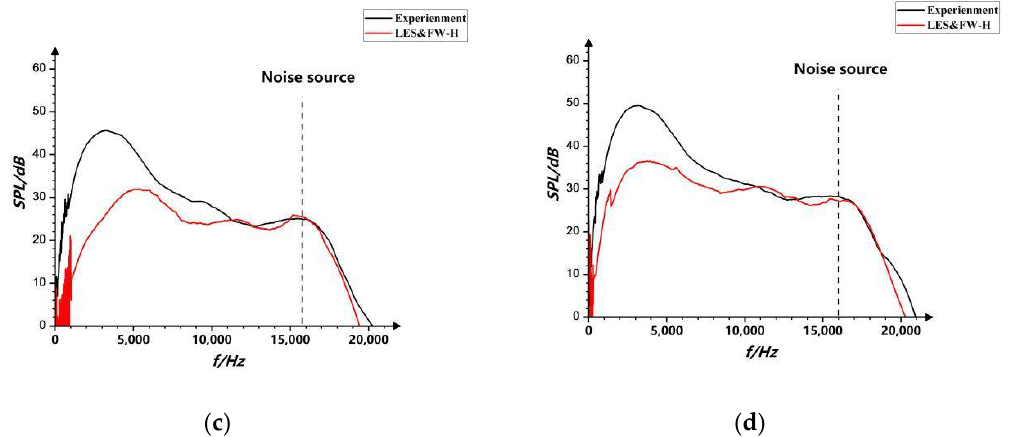
Figure 20. The wind angle 270°. ( a ) Wind speed 25 m/s; ( b ) Wind speed 30 m/s; ( c ) Wind speed 35 m/s; ( d ) Wind speed 40 m/s.